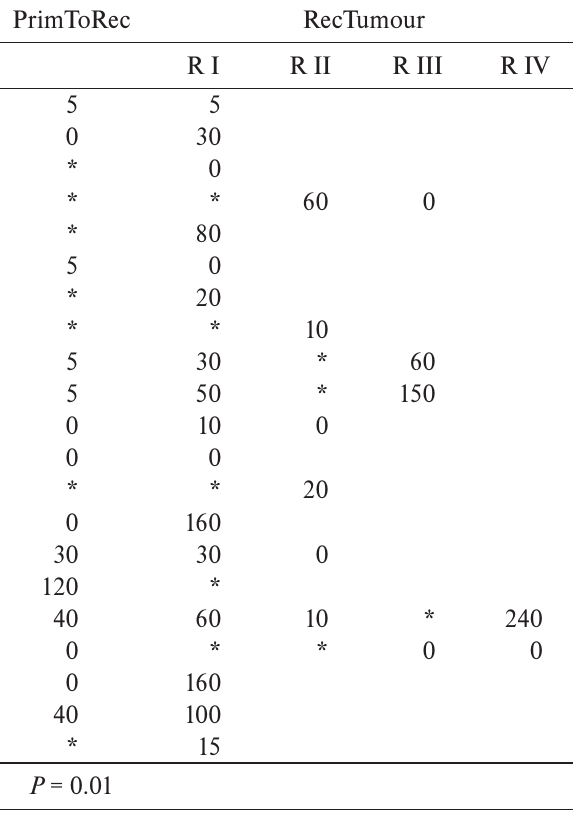
Table 1. Bcl-2 histoscore of myxoid and epithelial areas of primary-non-recurrent (PrimNonRec) and primary-to- recur (PrimToRec) pleomorphic adenomas.